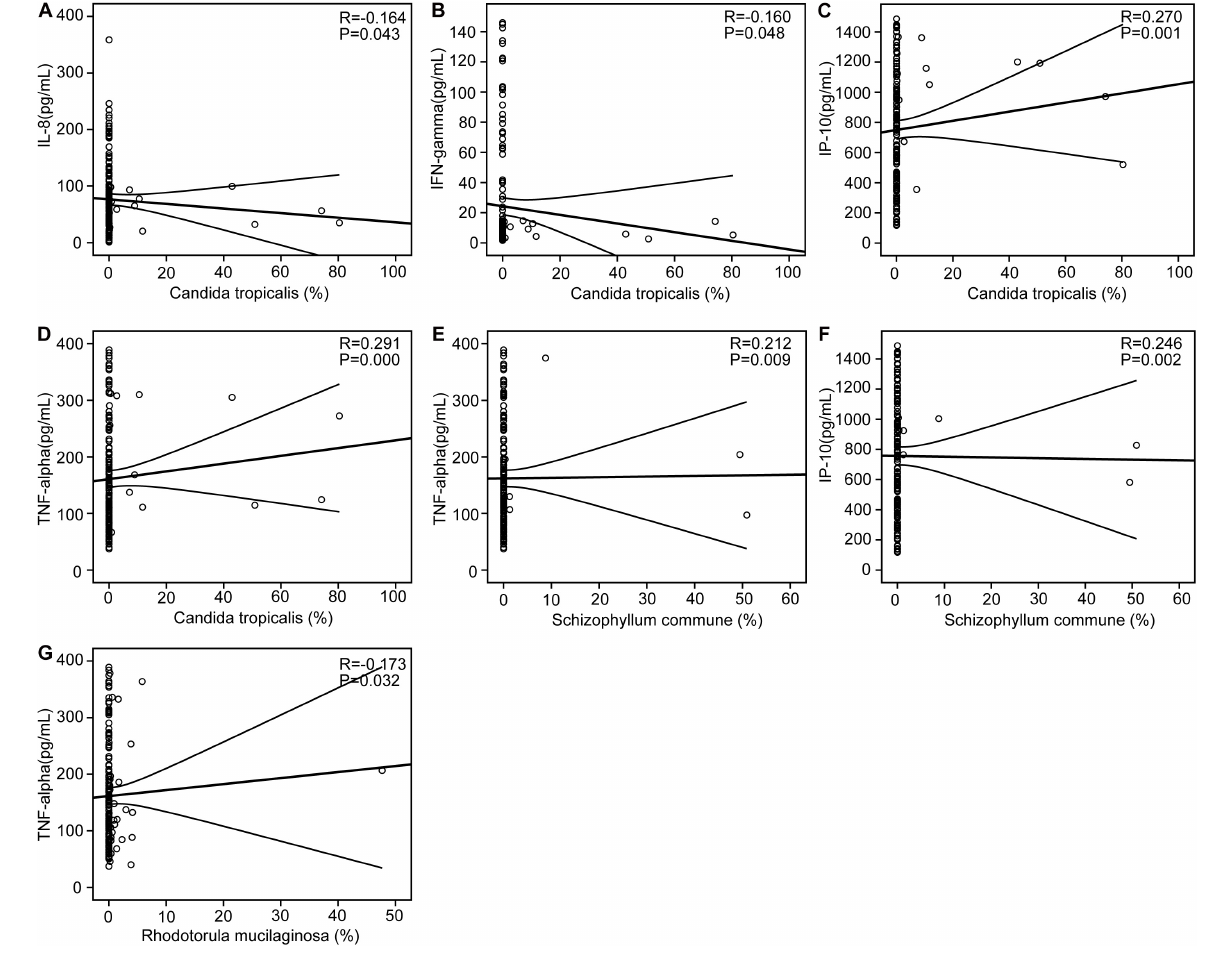
FIGURE 5 | Correlations between pro- and anti-inflammatory cytokines and chemokines with altered concentrations and the relative abundance of the key differential fungi. Correlation between the relative abundance of Candida tropicalis and the levels of IL-8 (A) , IFN- γ (B) , IP-10 (C) , and TNF- α (D) ; the relative abundance of Schizophyllum commune and the levels of TNF- α (E) and IP-10 (F) ; the relative abundance of Rhodotorula mucilaginosa and the levels of TNF- α (G) . Spearman’s rank correlation (R) and probability (P) were determined to evaluate the statistical